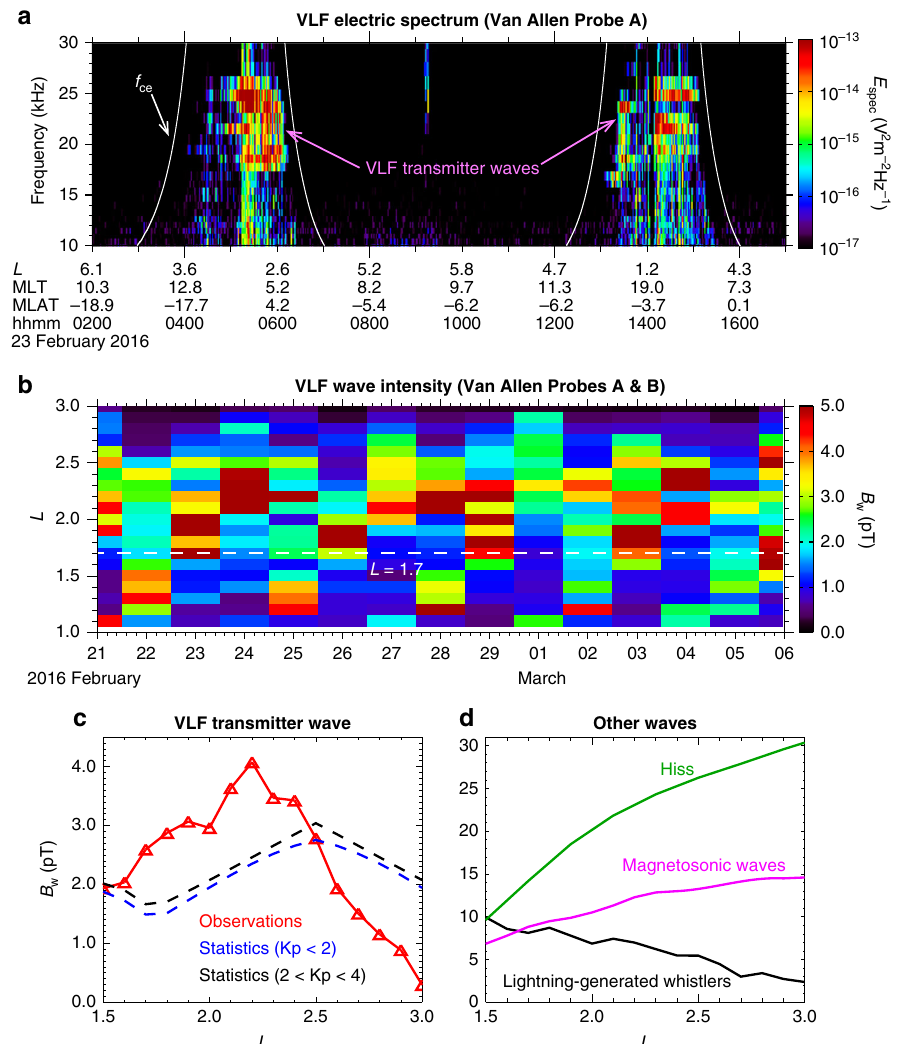
Fig. 2 In situ observations of VLF transmitter waves and statistical wave amplitudes of concurrent natural magnetospheric waves. a An example of electric power spectrogram of the high-frequency receiver (HFR) measurements by EMFISIS onboard Van Allen Probe A on 23 February 2016, where the white curves represent the electron cyclotron frequencies ( f ce ). The corresponding L- shell, magnetic local time (MLT), and magnetic latitude (MLAT) along the satellite trajectory are also labeled accordingly. b The radial pro fi le of daily -averaged magnetic wave amplitude (see more details in the section of “ Derivation of various plasma wave amplitudes ” in “ Methods ” ) of VLF transmitter waves integrated over 10 – 30 kHz based on the HFR measurements from both Van Allen Probes. Here the horizontal white line represents L = 1.7. c The radial pro fi le of root-mean-square (RMS) magnetic wave amplitudes of VLF transmitter waves averaged over all MLTs and the entire 15-day period (red line with triangles), and the statistical RMS wave amplitude of VLF transmitter waves under geomagnetically quiet (Kp < 2) and moderate (2 < Kp < 4) conditions 3 using blue and black dashed lines, respectively. Here Kp is a global geomagnetic activity index that is based on 3 h measurements from ground-based magnetometers around the world. d Radial pro fi les of statistical RMS wave amplitudes of lightning-generated whistlers 27 (black line), plasmaspheric hiss 28 (green line) and magnetosonic waves 29 (magenta line) measured by Van Allen Probes under moderate geomagnetic electrons (Fig. 3b), as estimated from the inverse of the pitch- angles close to 90° by the Landau resonance, the contribution of angle diffusion coef fi cients at the bounce loss cone indicated by which is small to the bifurcation of energetic electrons. The the white dashed curve. Regarding the natural plasma waves, scattering by plasmaspheric hiss, while much stronger, is pri- marily effective for electrons above ~100 keV near the bounce loss cone (Fig. 3g – i), and thus plays a dominant role in producing the slot region at higher energies between the inner and outer radiation belts 31 – 34 . Although lightning-generated whistlers also contribute to the pitch-angle scattering of tens of keV electrons at lower pitch-angles near the bounce loss cone (Fig. 3d – f), their effect is less ef fi cient than that of VLF transmitter waves at L ≤ 2.2, since the peak wave power of lightning-generated whistlers occurs at much lower frequencies. Both hiss and lightning-